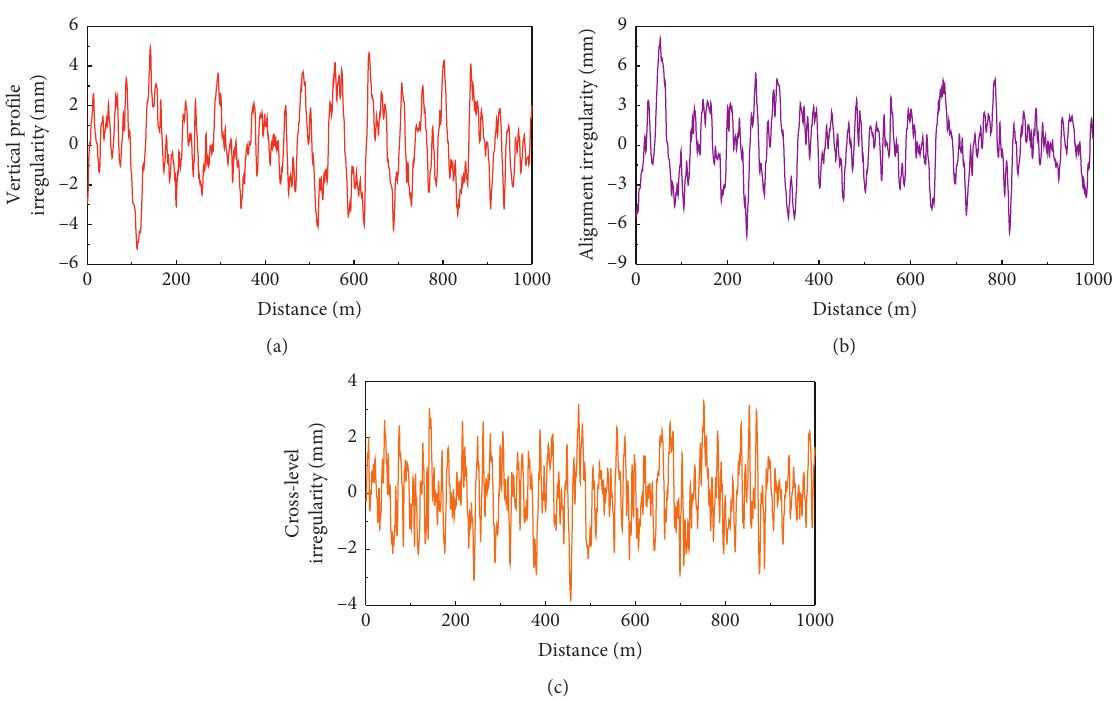
Figure 8: Irregularity sample of the rail. (a) Vertical profile irregularity. (b) Alignment irregularity. (c) Cross-level